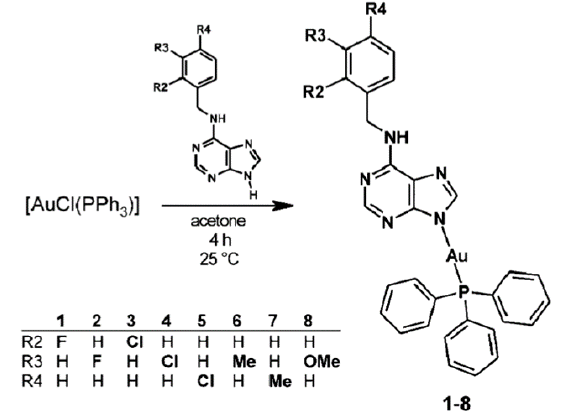
Figure 3. Synthetic pathway for the preparation of the gold(I) complexes (1 – 8)